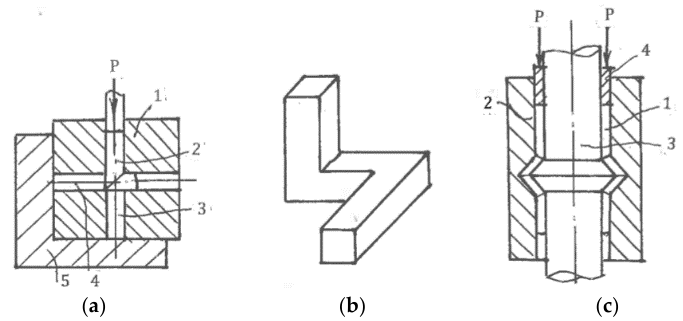
Figure 16. Simple shear SPD: ( a ) Multi-pass ECAE in the rotary die; ( b ) Multi-turn ECAE; ( c ) Tubular channel angular pressing. channel angular